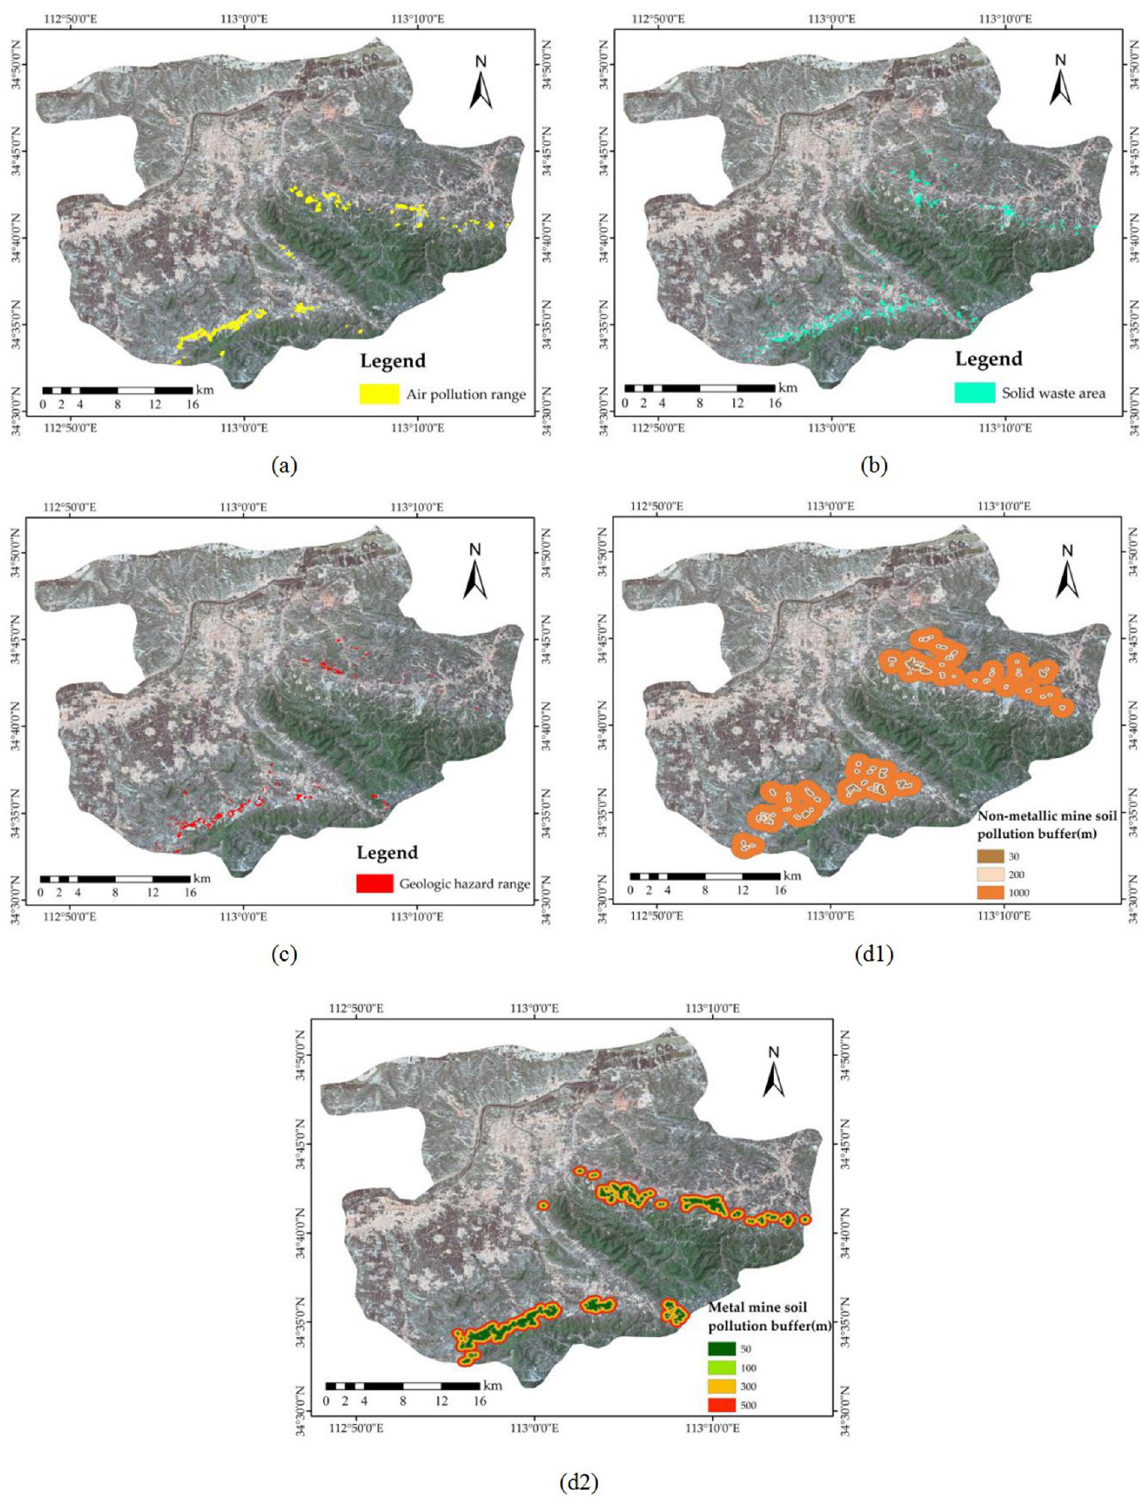
Figure 7. New factors in the improved evaluation system. ( a ) Air pollution range; ( b ) solid waste area; ( c ) geological hazard range; ( d1 ) non-metallic mine soil pollution buffer; and ( d2 ) metal mine soil pollution buffer. The Figure is created using ArcGIS ver.10.3 (https:// www. esri.